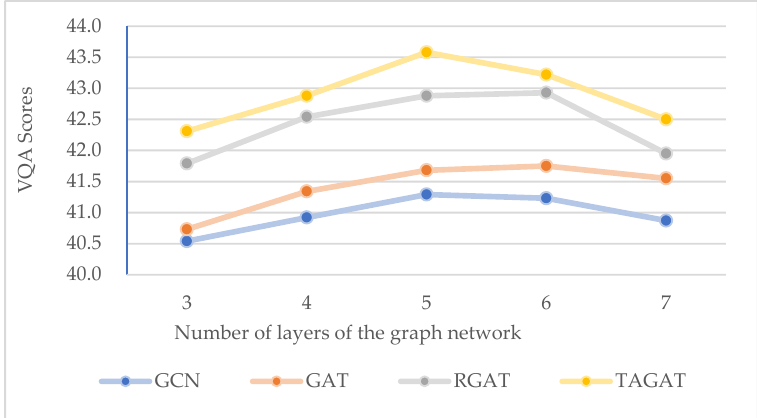
Figure 7. The Influence of Graph Reasoning Module.